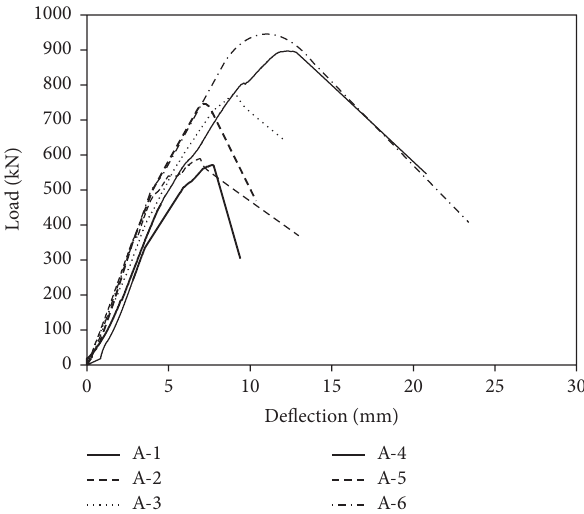
Figure 11: Load-deflection curves for amount of shear reinforce- ment.